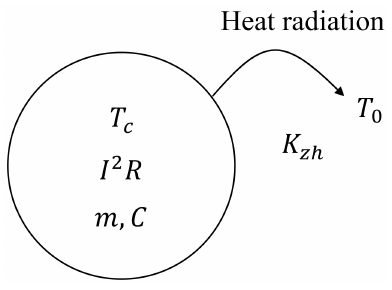
Figure 4. Heat generation and dissipation by the